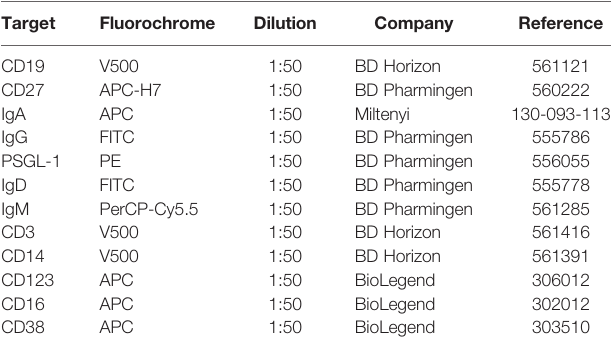
TABLE 4 | Flow cytometry antibodies for characterization of human immune